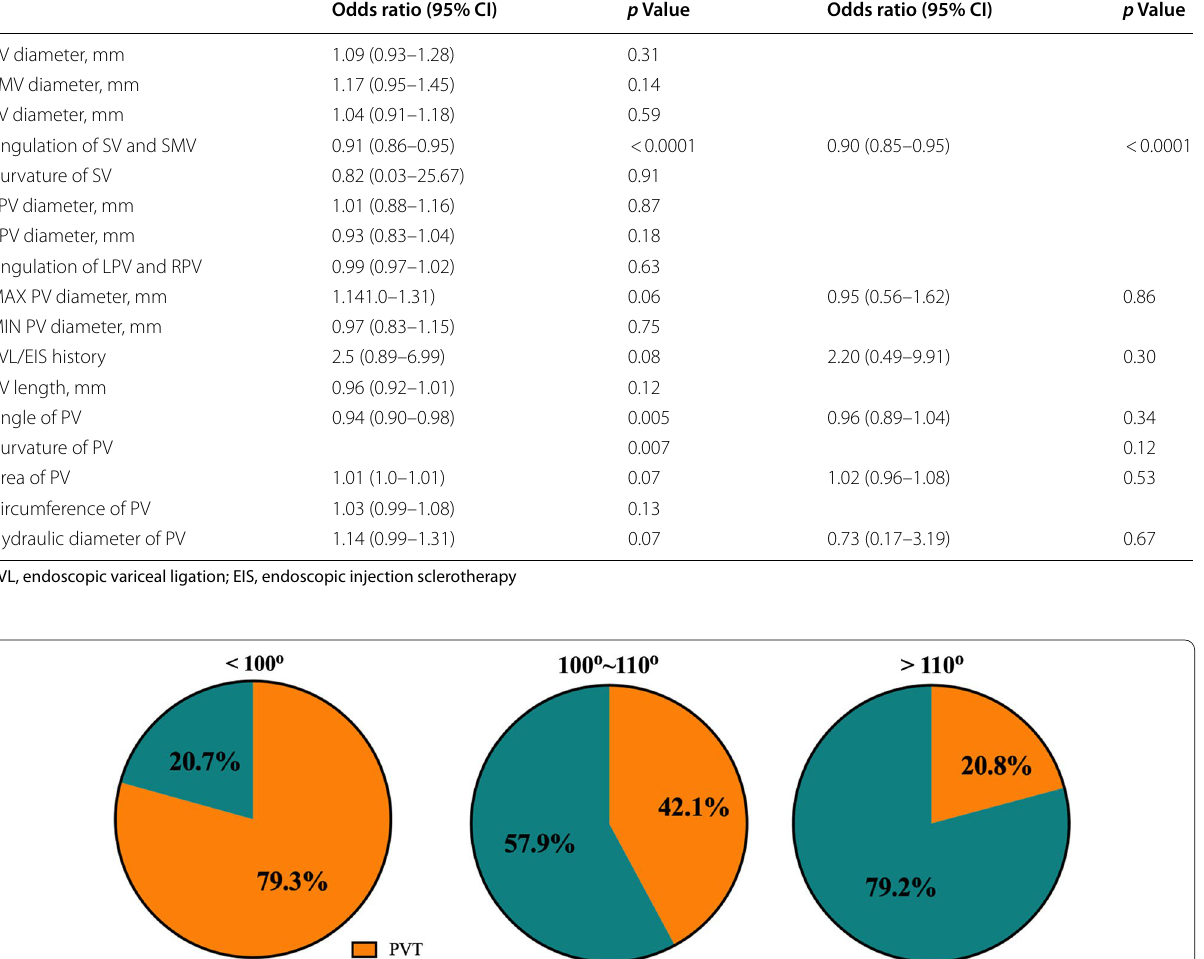
Table 3 Univariable and multivariable linear regression analyses of parameters associated with PVT